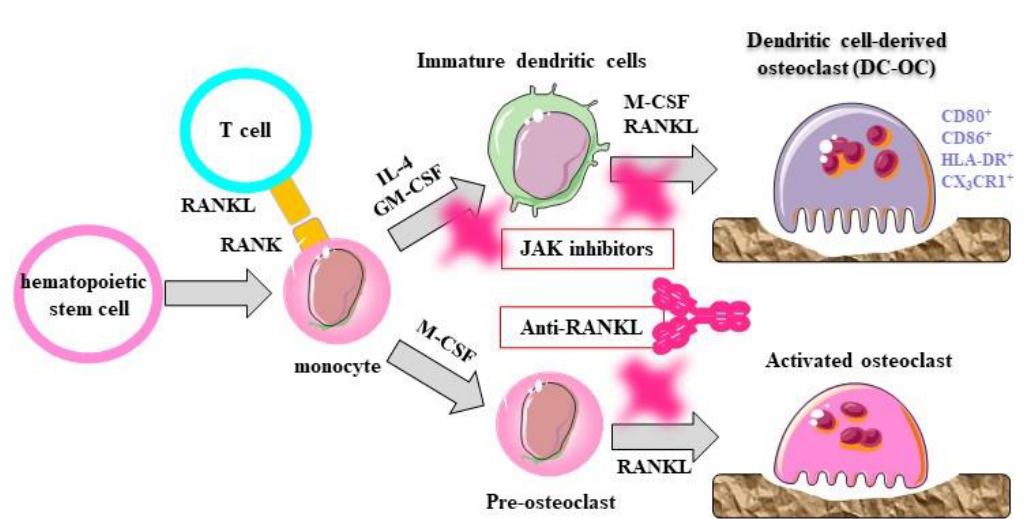
Figure 4. Dendritic-cell-derived osteoclasts in rheumatoid arthritis. Osteoclasts derived from dendritic cells by stimulation of GM-CSF, M-CSF, and RANKL played pathological roles in chronic inflammatory and destructive synovitis via osteoclastic bone resorption, as well as costimulatory activation of T cells.